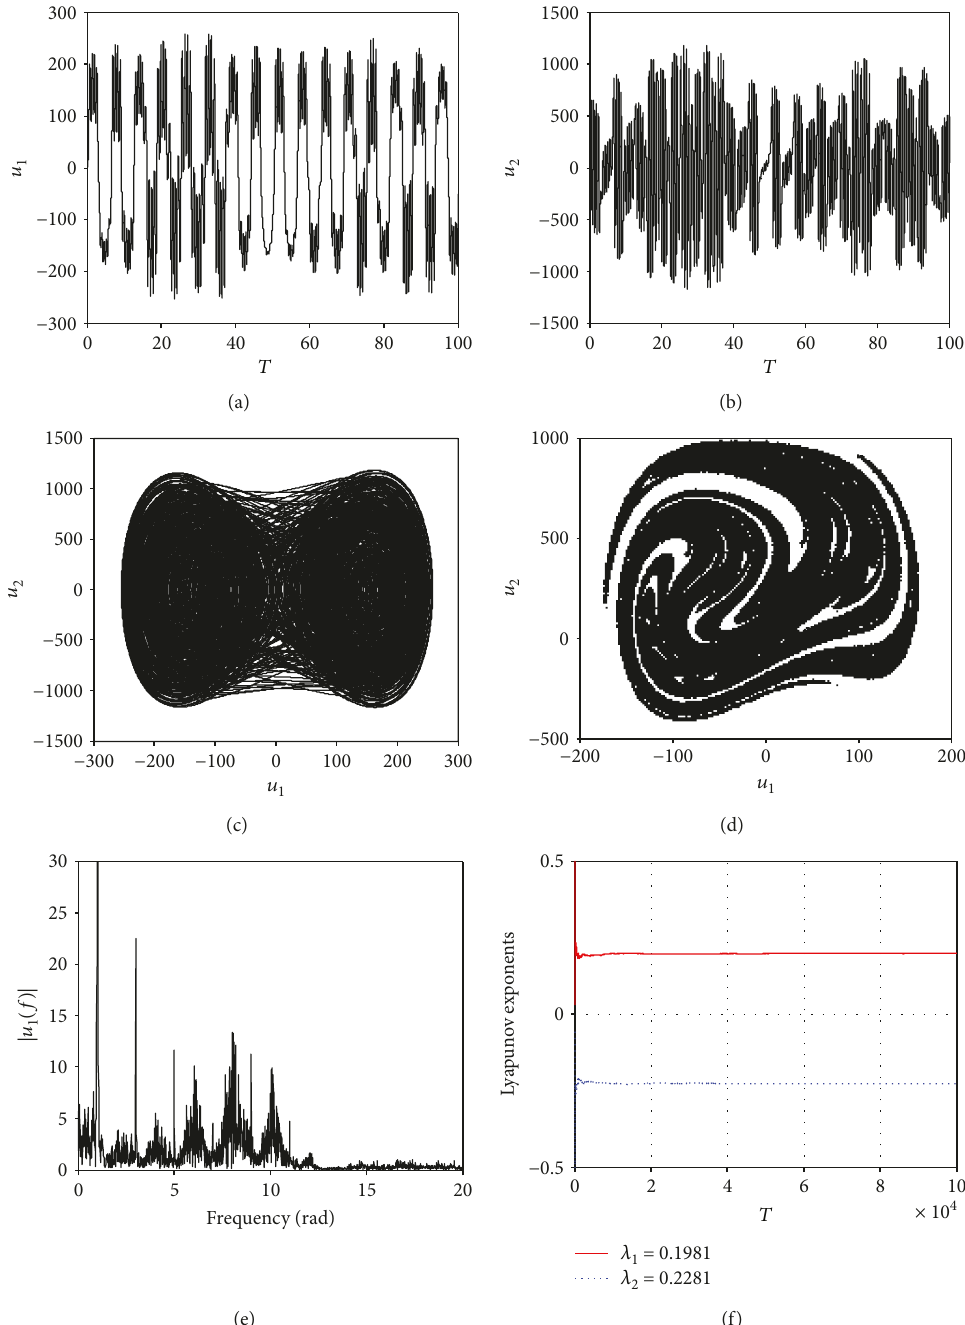
Figure 3: (a) Time history of state u 1 , (b) time history of state u 2 , (c) phase portrait, (d) Poincaré map, (e) power spectral density (FFT) to u 1 , and (f) Lyapunov